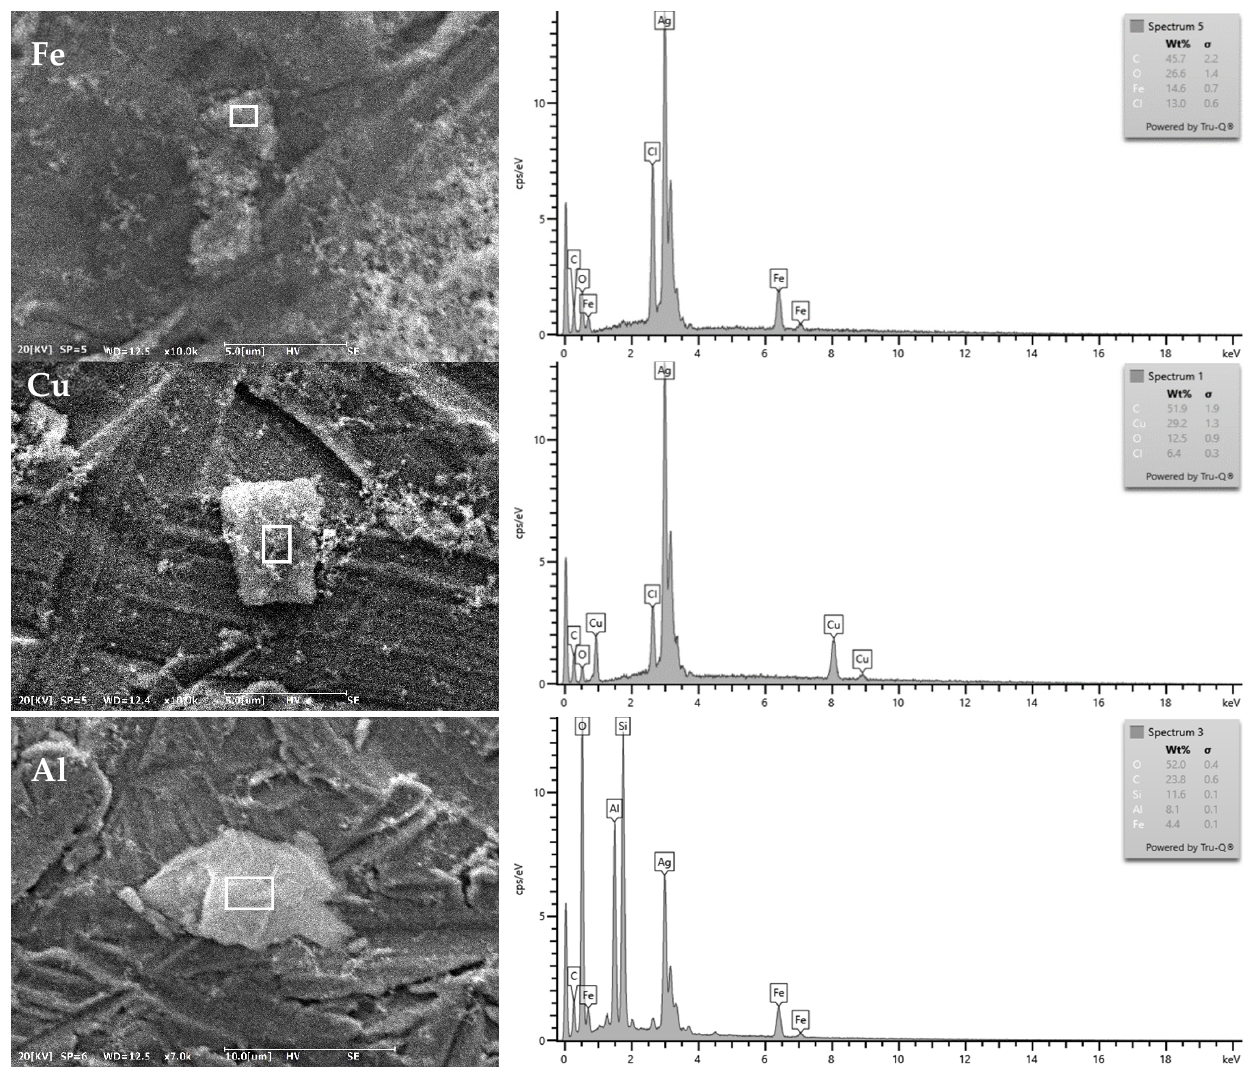
Figure 8. SEM-EDS elemental analysis of metal particles from incineration experiment of waste LDPE film collected in DangJin.